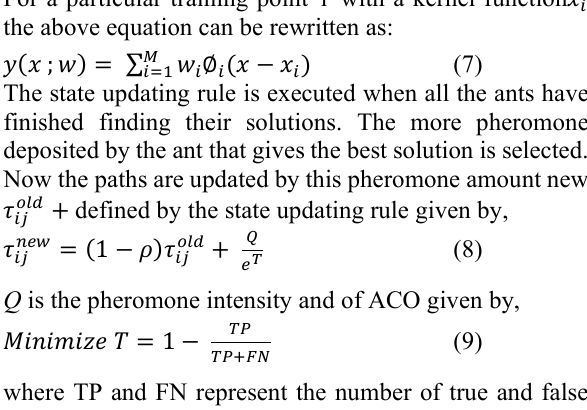
Table 1. Parameter Values of ACO Algorithm Sl.No.